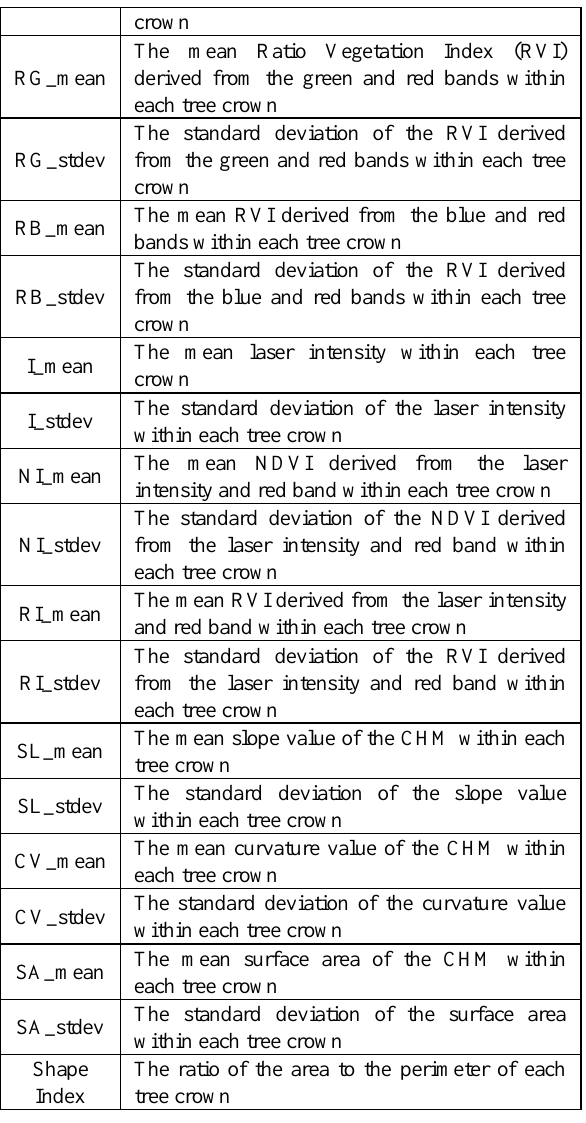
Table 1. Definitions of the 27 image-based